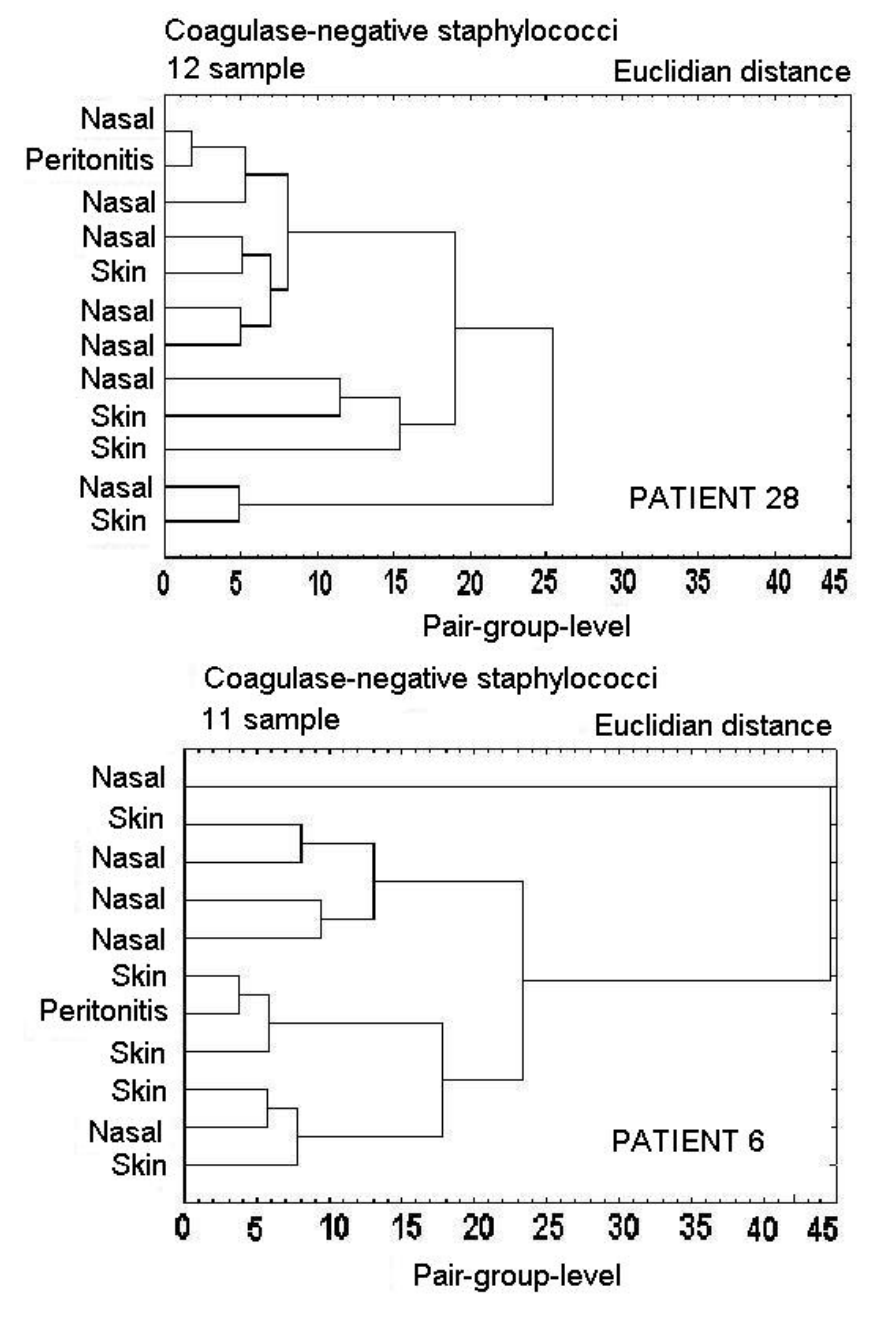
Figure 3: Similarity dendrograms drawn based on inhibition halos obtained by using the agar disk diffusion technique for coagulase-negative staphylococci isolated from the nasal cavity, pericatheter skin and peritoneal effluent of two patients undergoing peritoneal